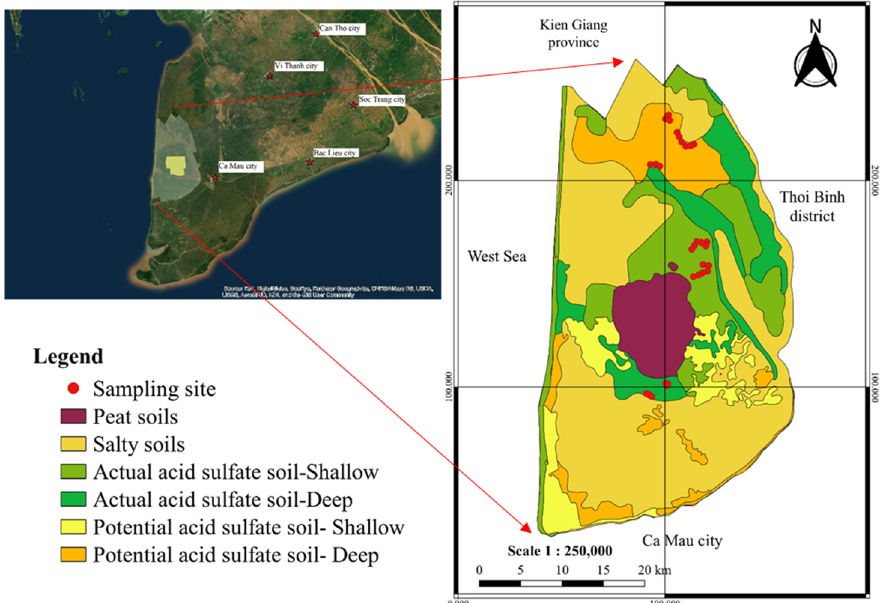
Figure 1. Map of the sampling locations in U Minh Ha National Park.